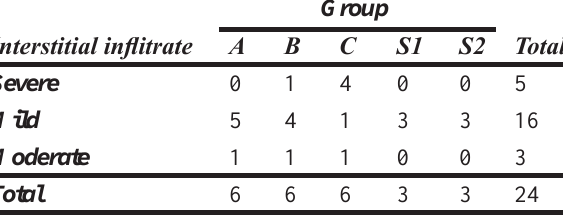
TABLE 3 - Pancreatic necrosis in each group